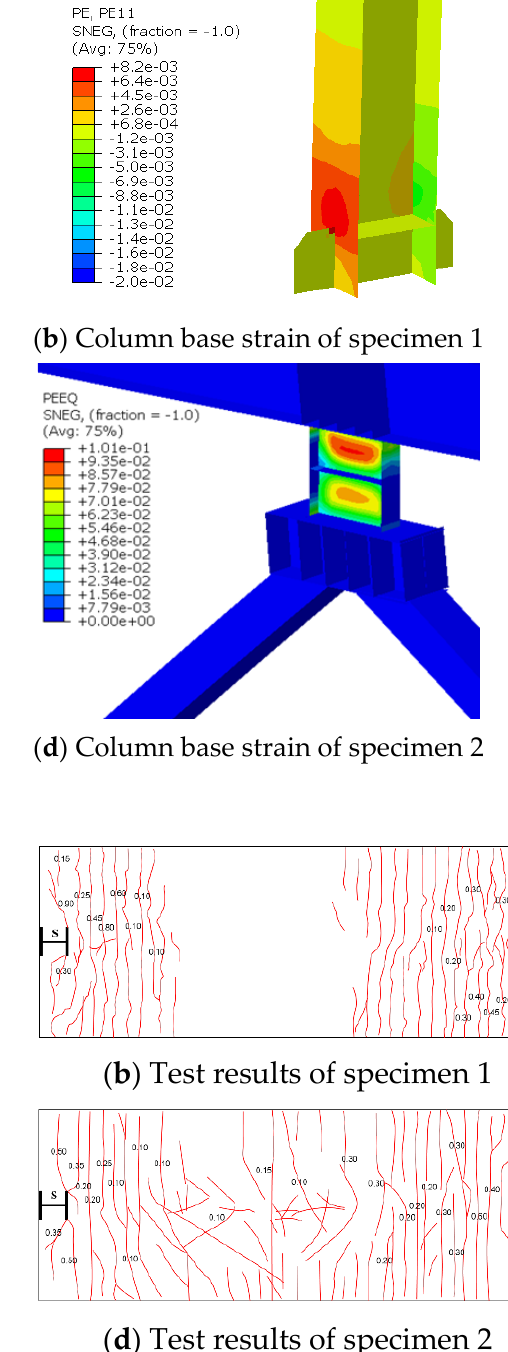
( d ) Drift ratio = 1/42.9 Figure 9. Stress cloud of the steel frame of specimen 2. Figure 10a,b illustrates the local plastic strain nephograms of the beam end and bot- tom of the column when the failure drift ratio of specimen 1 has been reached. The fol- lowing simulation results are consistent with the experimental results. The maximum plastic strain at the beam end is located at the flange widening. Obvious buckling or tear- ing failure initially occurred at the flange widening during the test. The maximum plastic strain at the column end is located at the upper part of the column end stiffener. When